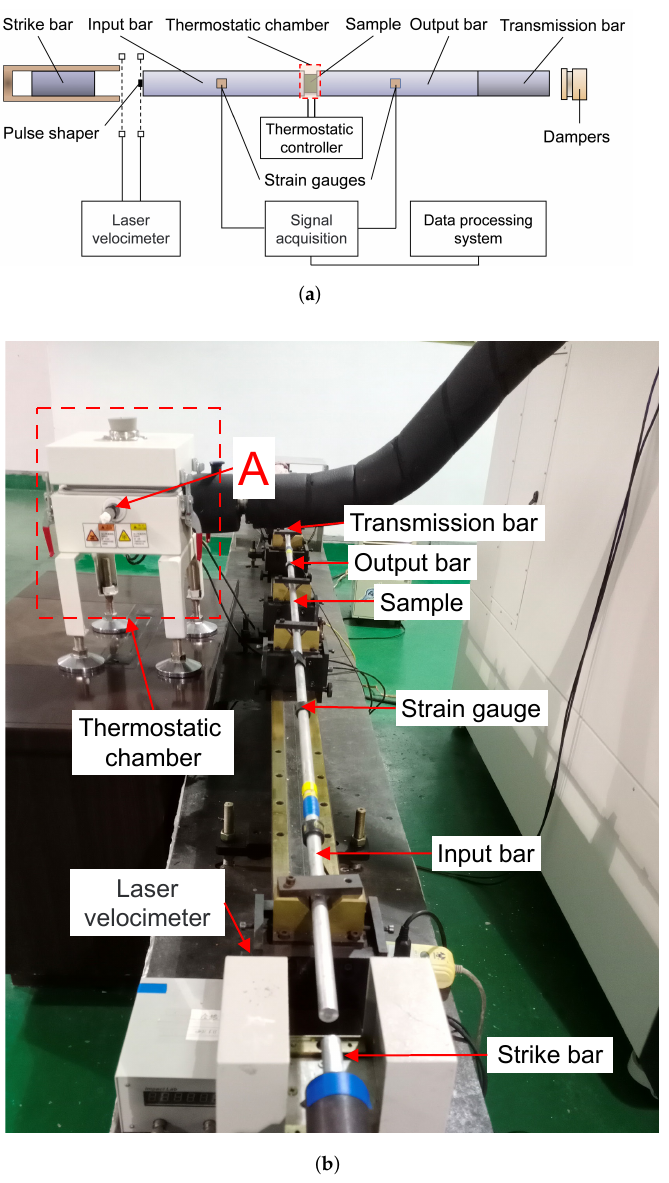
Figure 2. SHPB experimental setup. ( a ) schematic; ( b )